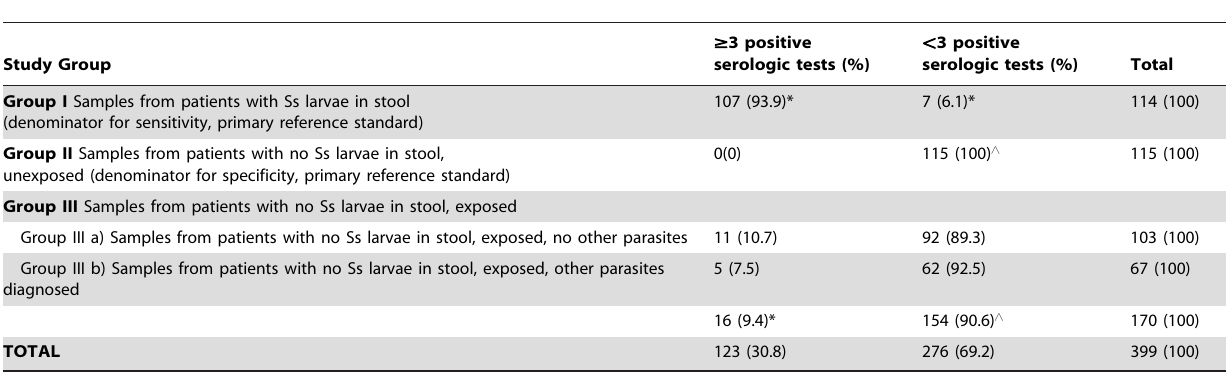
Table 1. Proportion of samples with $ 3 positive serologic tests.